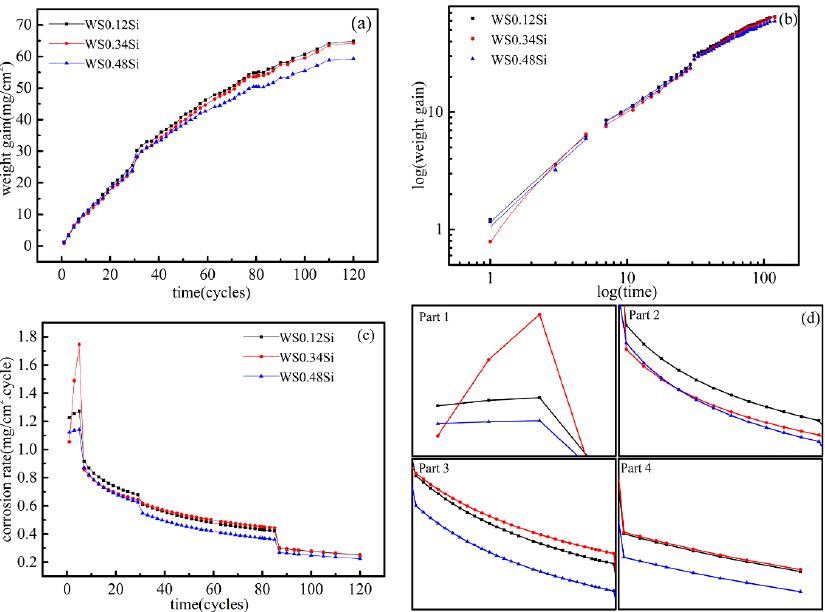
Figure 2. Corrosion kinetics evolution of three experimental steel groups in simulated marine environment: ( a ) Weight gain curve; ( b ) fitting curve; ( c ) corrosion rate curve; ( d ) the magnification of